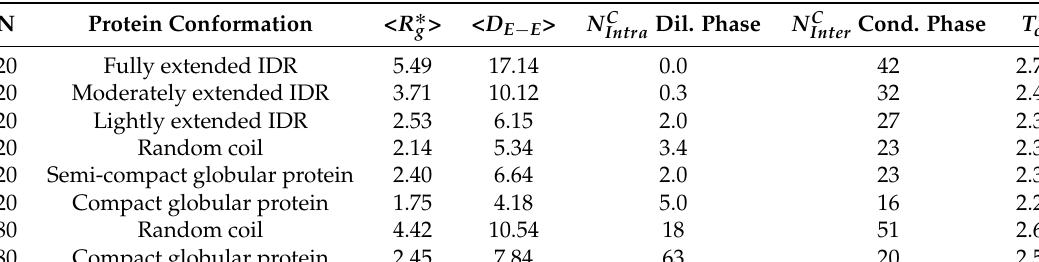
Table 1. Structural conformation, molecular contacts and thermodynamic stability of the protein condensates. Average radius of gyration ( ă R ˚ g ą ), end-to-end distance ( ă D E ´ E ą ) and number of intra-molecular contacts per protein ( N C per protein in the condensed phase ( N C proteins. The given values of ă R ˚ g ą , ă D E ´ E ą , N C proteins correspond to a temperature of T ˚ “ 0.72 T ˚ coexisting phase of interest at such temperature. T ˚ radius of gyration and the number of intra-molecular contacts for the globular structured proteins are